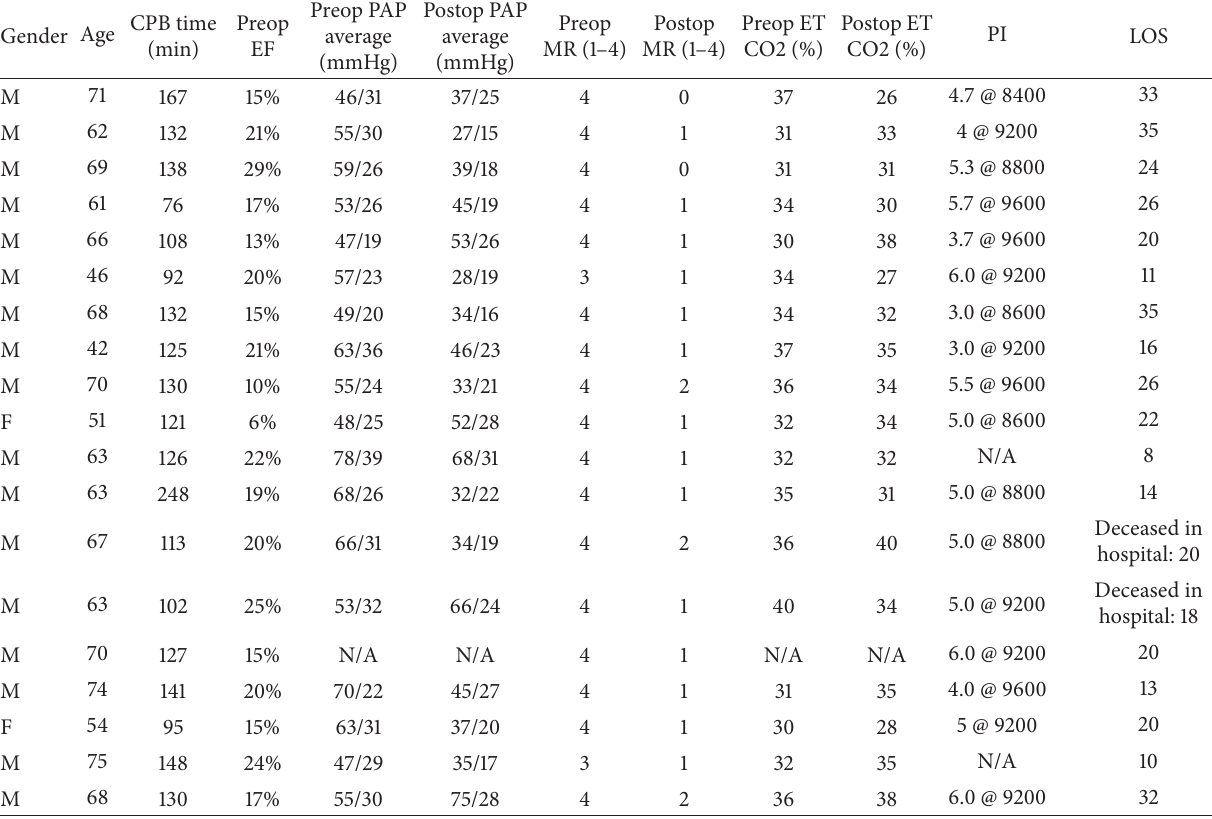
Table 2: Preoperative and postoperative clinical characteristics of 19 patients undergoing simultaneous MV repair and LVAD insertion. CPB time Gender Age